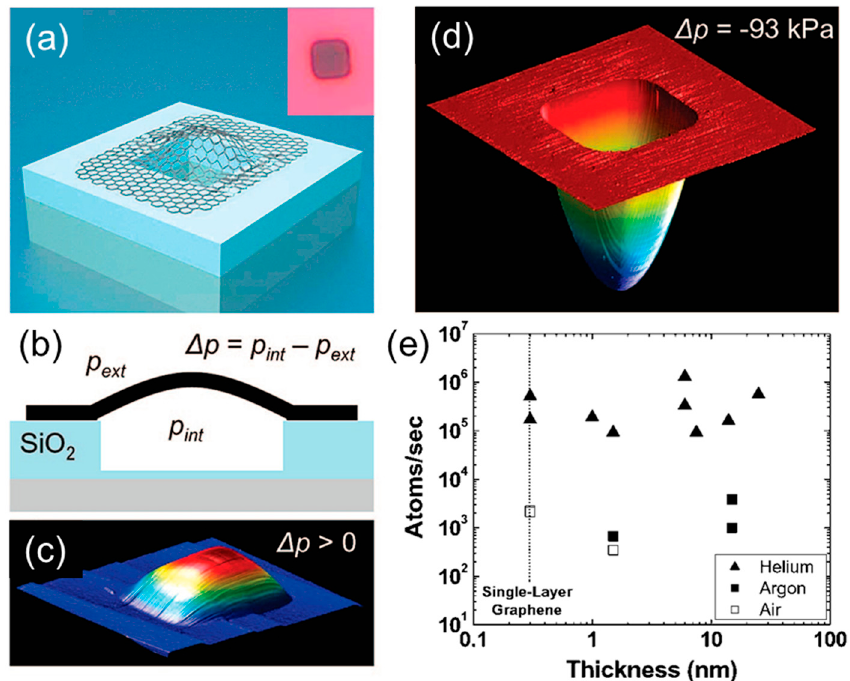
Figure 1. ( a ) Schematic of a microchamber sealed by a graphene drumhead. Inset is the optical image of graphene sealed SiO 2 microchamber with dimensions of 4.75 µm × 4.75 µm × 380 nm. ( b ) Cross-sectional schematic of the graphene sealed microchamber. AFM image of the graphene sealed microchamber with ( c ) p int > p ext and ( d ) p int < p ext . ( e ) Effect of the thickness of the graphene drumhead on the permeation rates of various gases. Adapted with permission from [14]. American Chemical Society (2008).